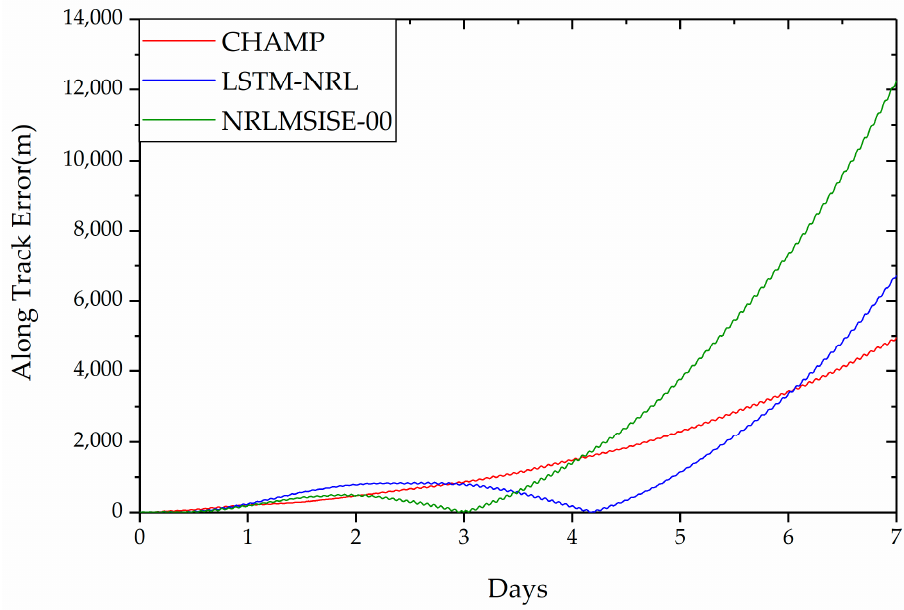
Figure 12. The CHAMP orbit prediction errors in the along track direction in 7 days.